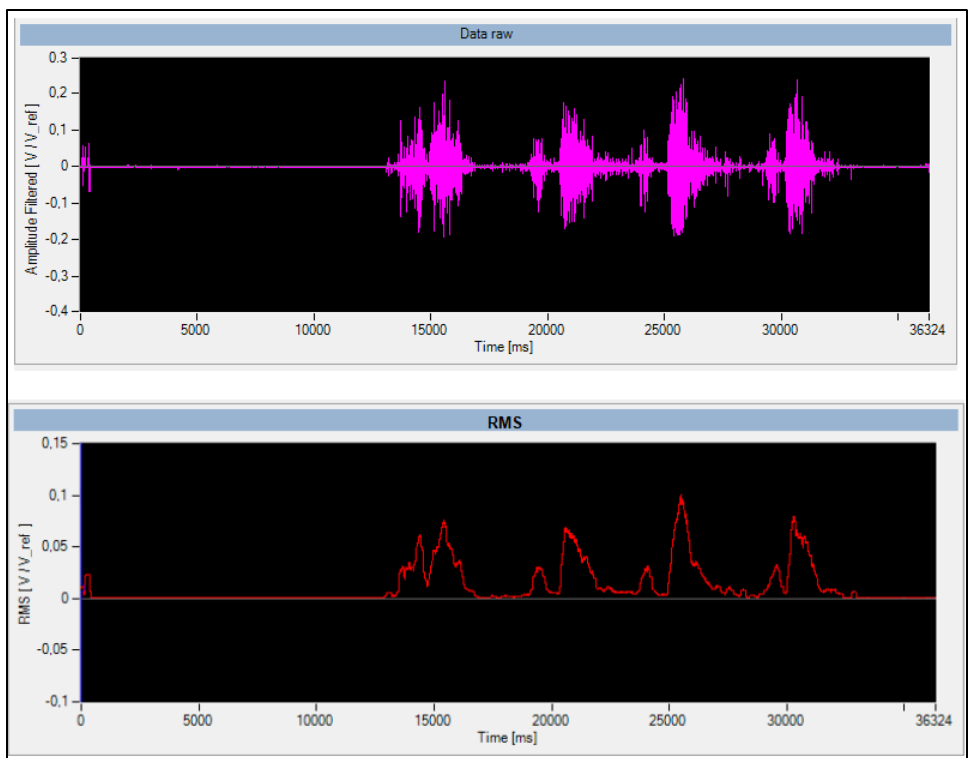
Figure 2. sEMG of vastus lateralis muscle in an exercise of squat: RAW data and RMS wavelet filtered.